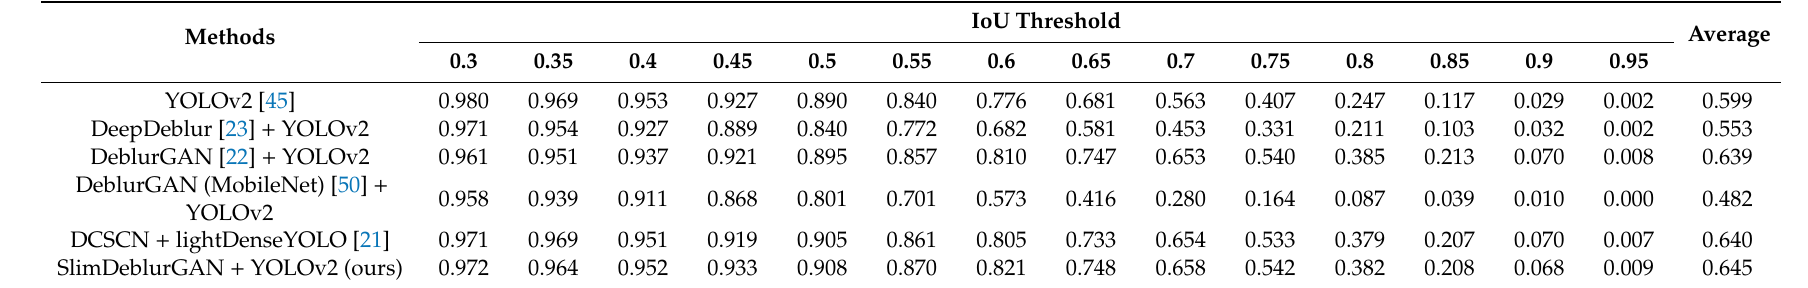
Table 9. Comparisons of precision on SMBD-DB1.